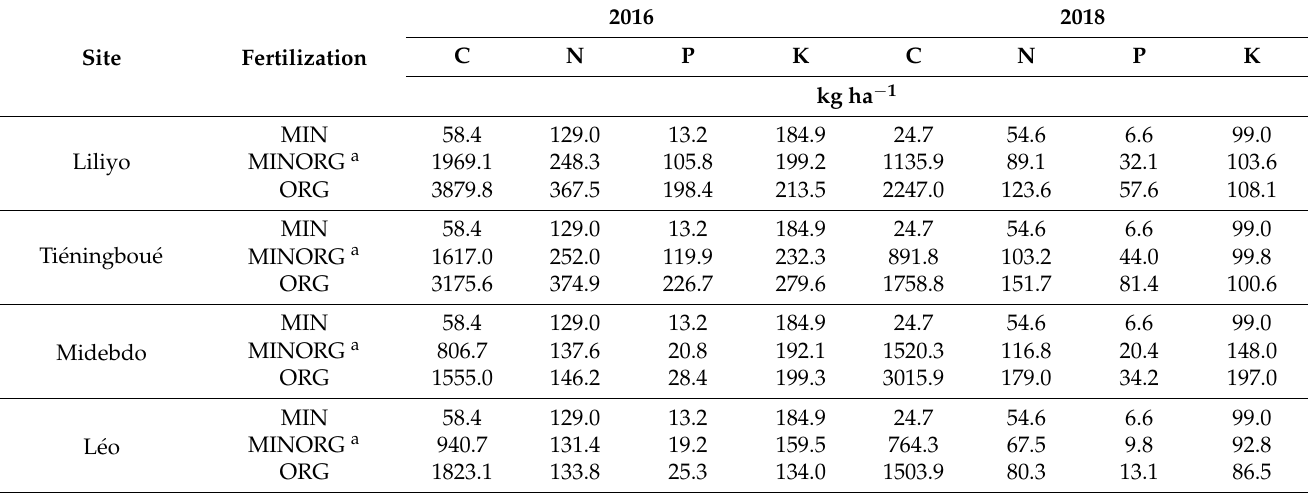
Table 1. Amount of C, N, P, and K added by mineral and/or organic fertilizers in 2016 and 2018 on